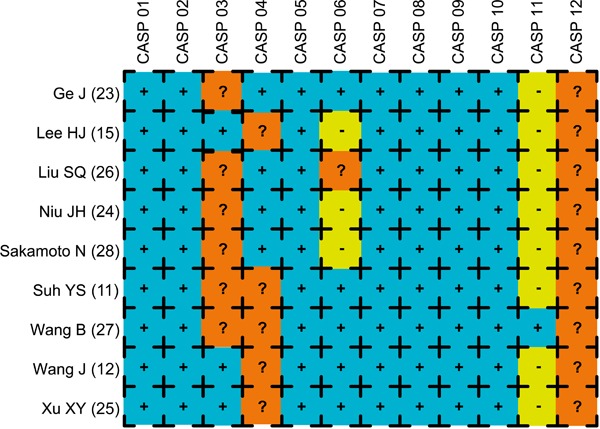
The Critical Appraisal Skills Programme (CASP) score for assessing the
methodological quality of the nine enrolled cohort studies. CASP: <http://www.casp-uk.net/>.